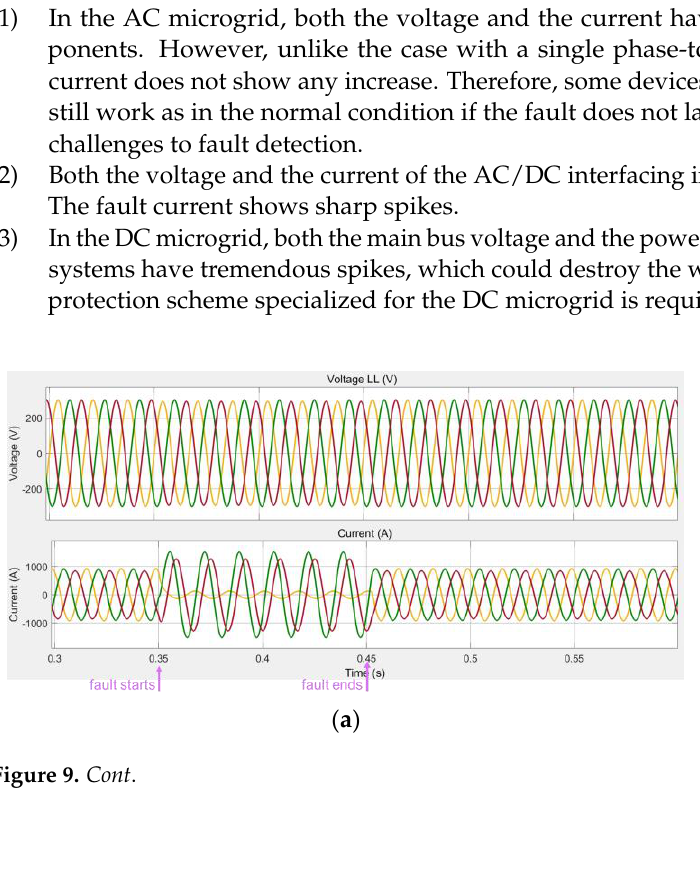
Figure 8. Control diagram of grid-following inverter controller.